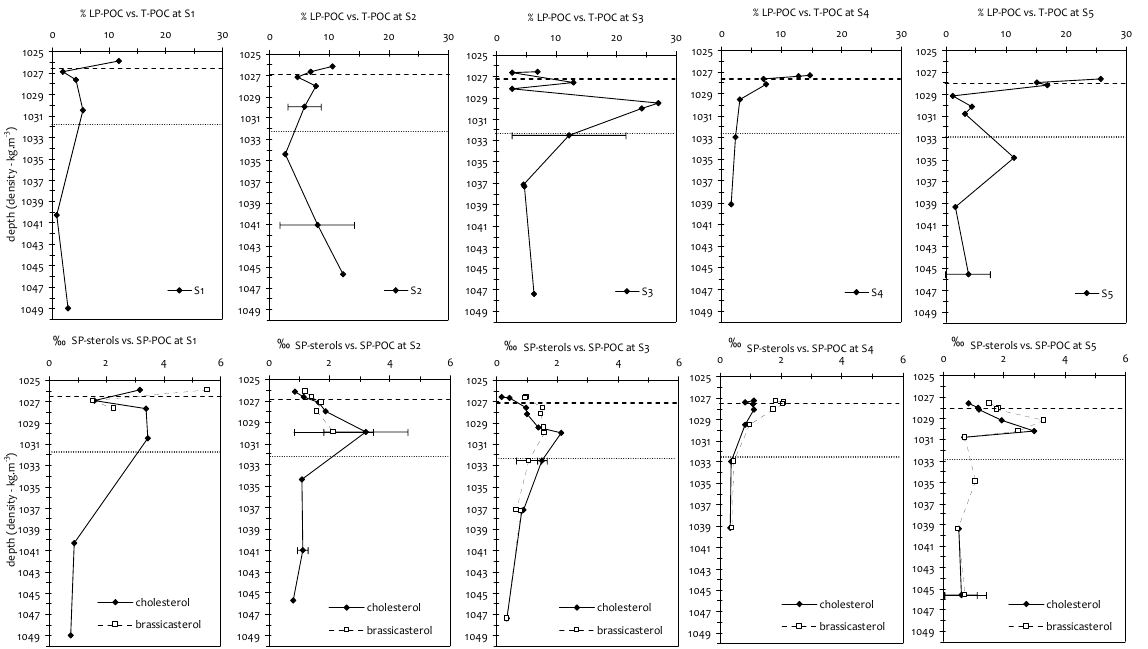
Fig. 2. Upper panel: profiles of large particle ( > 53µm) POC content over total POC content (in %). Lower panel: profiles of small particle (1–53µm) cholesterol and brassicasterol content over small particle POC content (in ‰). Y-axis depth is shown as seawater density; the 100m (dashed line) and 1000m (dotted line) depth horizons are shown. The standard error is estimated as ± 30% for brassicasterol and cholesterol. Error bars shown represent the average standard deviation ( ± 1 σ SD ) for two close-by samples (see also Supplement Annex